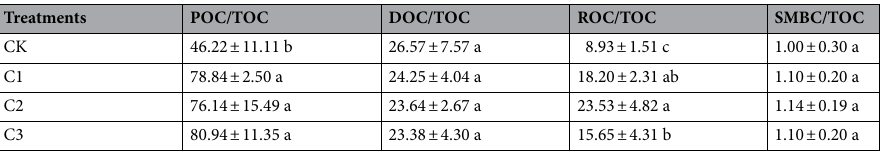
Table 2. Percentage of different organic carbon components in soil total organic carbon (%). Mean ± SD, different lowercase letters in the same column indicate 5% difference between treatments. CK, the volume ratio of soft rock to sand is 0:1; C1, the volume ratio of soft rock to sand is 1:5; C2, the volume ratio of soft rock to sand is 1:2; C3, the volume ratio of soft rock to sand is 1:1; TOC soil total organic carbon; POC particulate organic carbon; DOC dissolved organic carbon; ROC oxidized organic carbon; SMBC soil microbial biomass